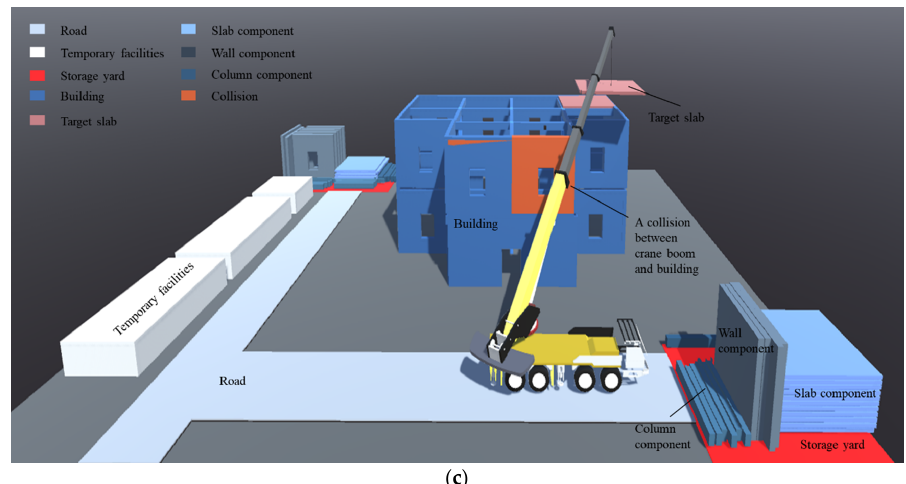
Figure 7. The initially selected type QY90K, which does not satisfy the constraints. ( a ) Unsatisfied environmental constraint. ( b ) Unsatisfied operation constraint. ( c ) Unsatisfied safety constraint.